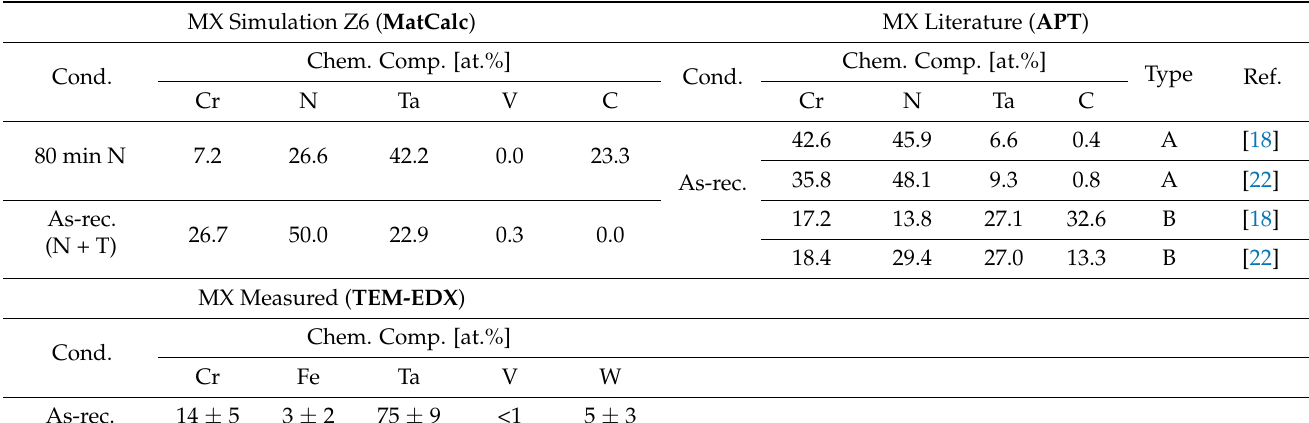
Table 8. MX chemistry of 80 min N + cond. 1 in MatCalc (this work), TEM-EDX (this work) and APT